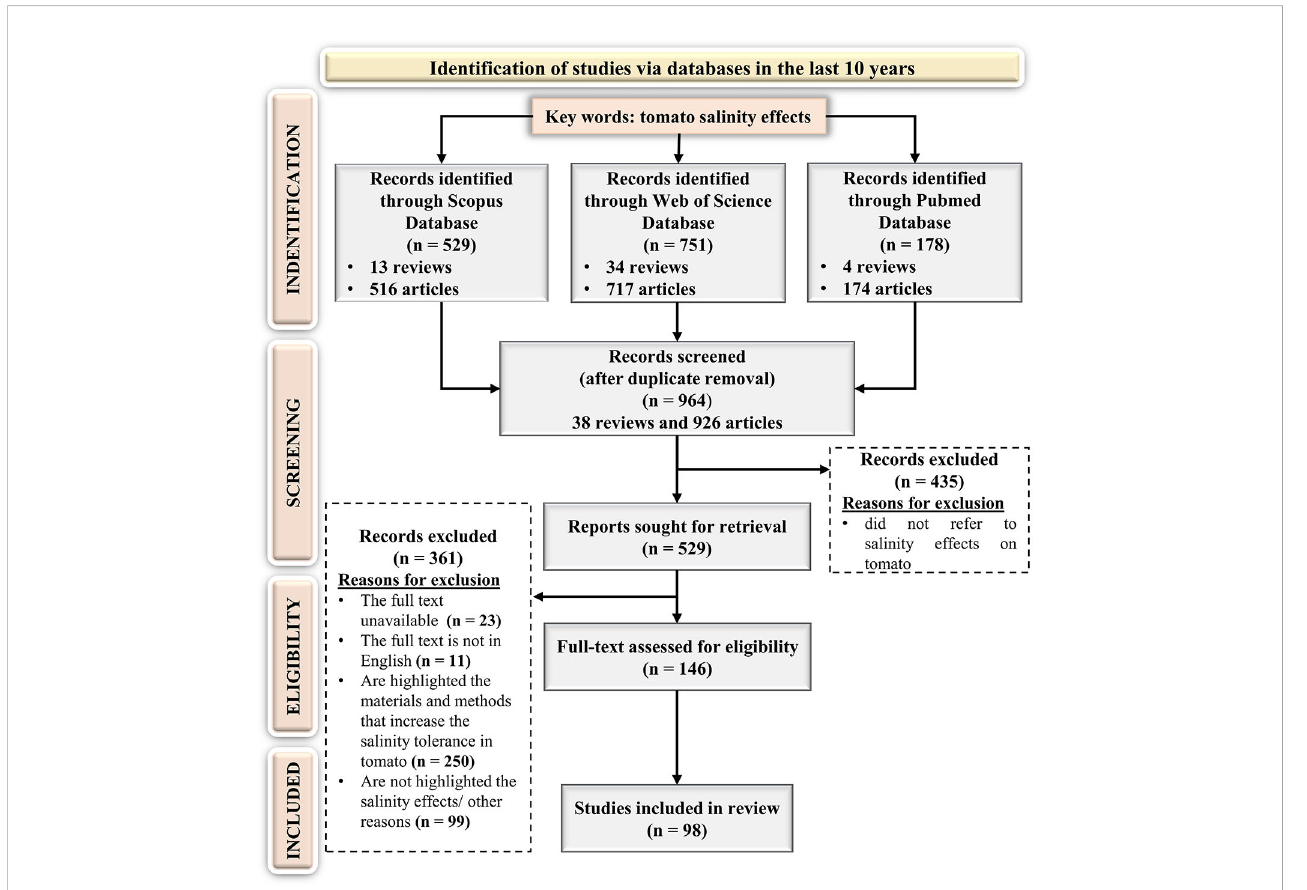
FIGURE 3 Preferred Reporting Items for Systematic Reviews and Meta-Analyses PRISMA fl ow diagram for the targeted systematic